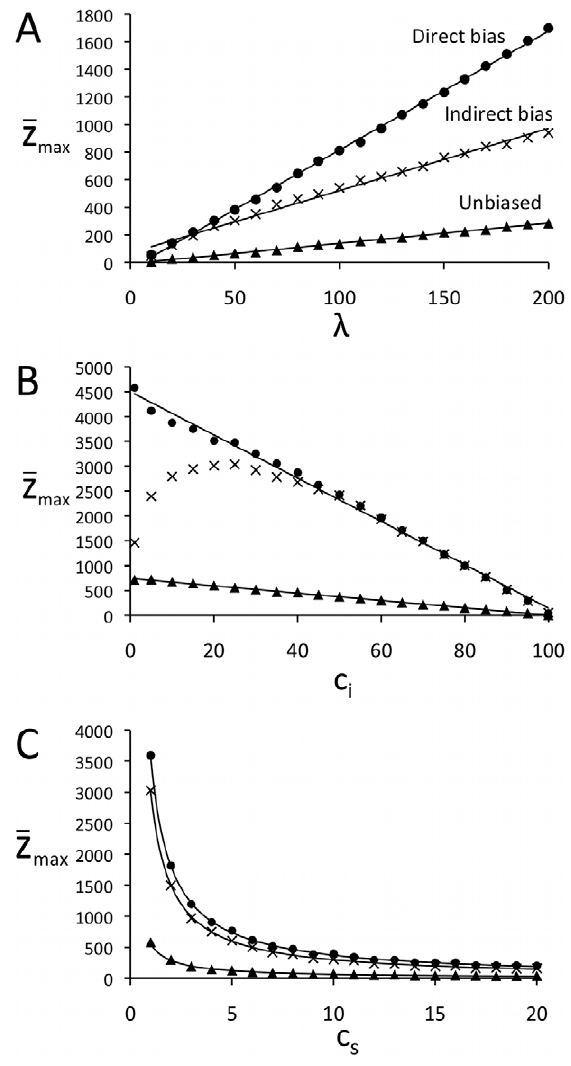
Figure 6. The effect on maximum cultural complexity Z max of varying (A) lifetime effort budget l (with constant c i =10, c s =5), (B) innovation cost c i (with constant c s =1, l =100), and (C) copying cost c s (with constant c i =10, l =100). Circles indicate direct bias, crosses indicate indirect bias and triangles indicate unbiased transmission. Lines show best-fit functions, in (A) showing a positive linear relationship between Z max and l for direct bias (R 2 =0.999), indirect bias (R 2 =0.991) and unbiased transmission (R 2 =0.998); in (B) showing a negative linear relationship between Z max and c i for direct bias (R 2 =0.995) and unbiased transmission (R 2 =0.999), but for indirect bias only for larger c i values (for c i . 30, R 2 =0.990), with lower c i values generating lower Z max values than expected (no best-fit line drawn); and in (C) showing an inverse power law relationship between Z max and c s for direct bias (R 2 =0.997), indirect bias (R 2 =0.997) and unbiased transmission (R 2 =0.992). Other parameters: N =100, X =100, m i = m s =0, all results are the average of 100 independent